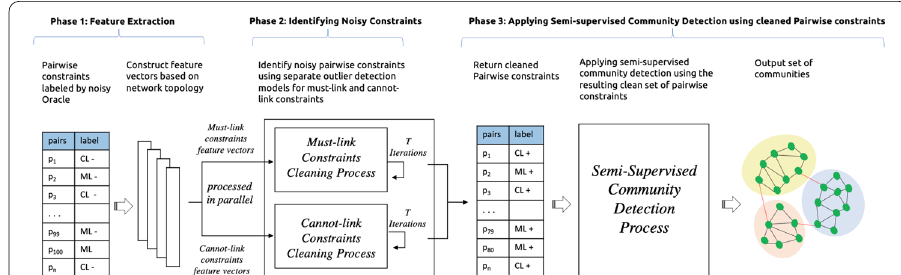
Fig. 1 An illustration of the overall pairwise constraint cleaning